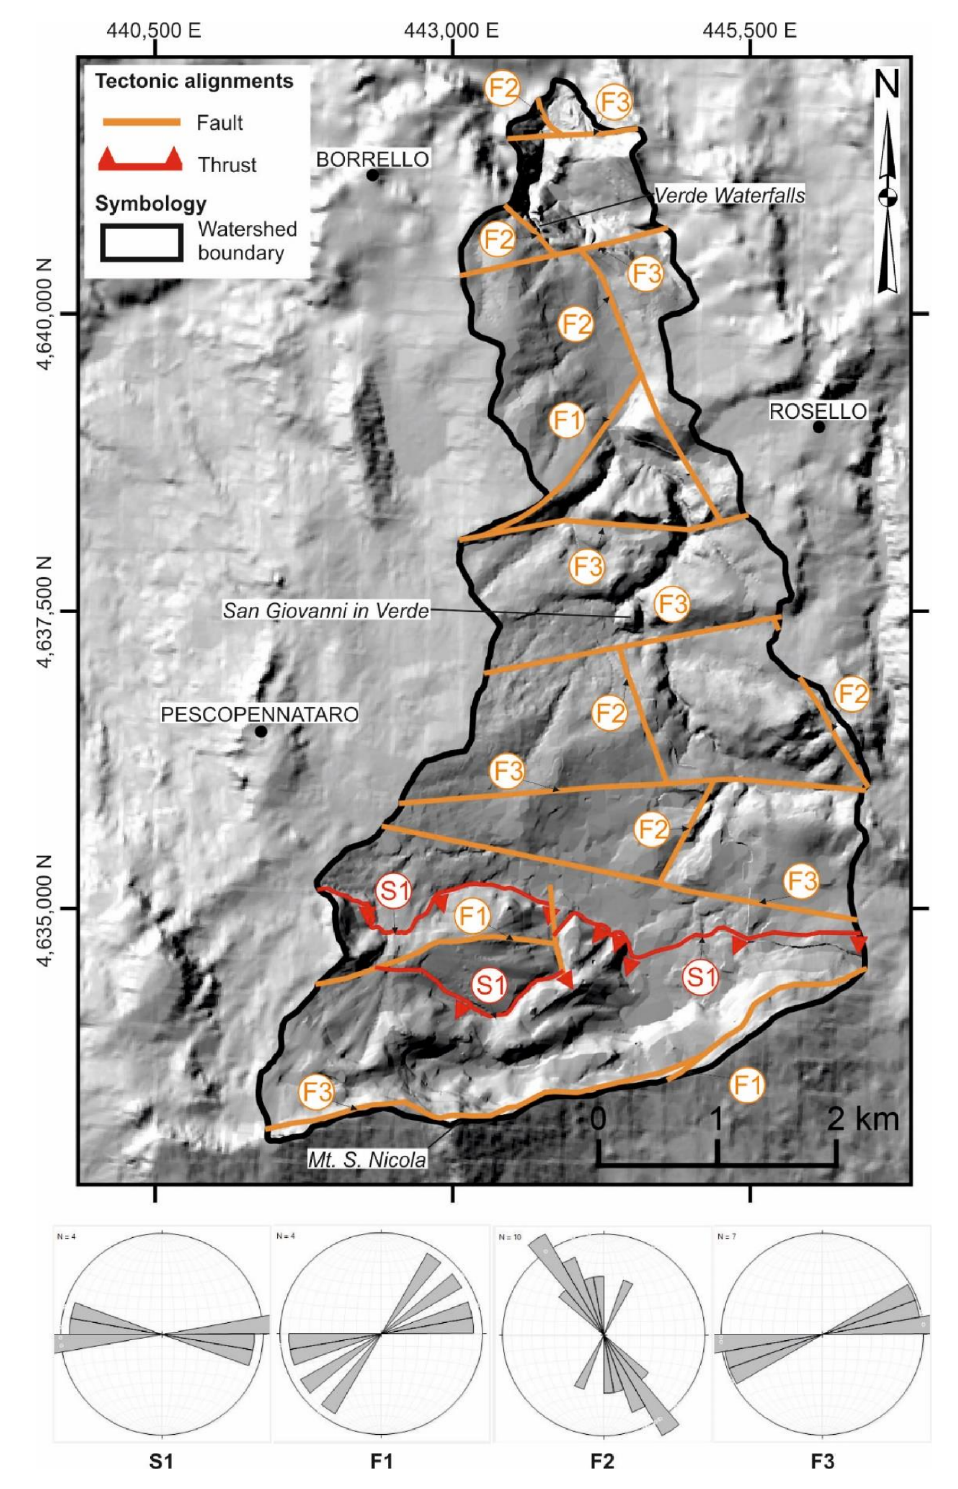
Figure 12. Morphotectonic scheme showing tectonic features, the relevant azimuthal distributions, and the different